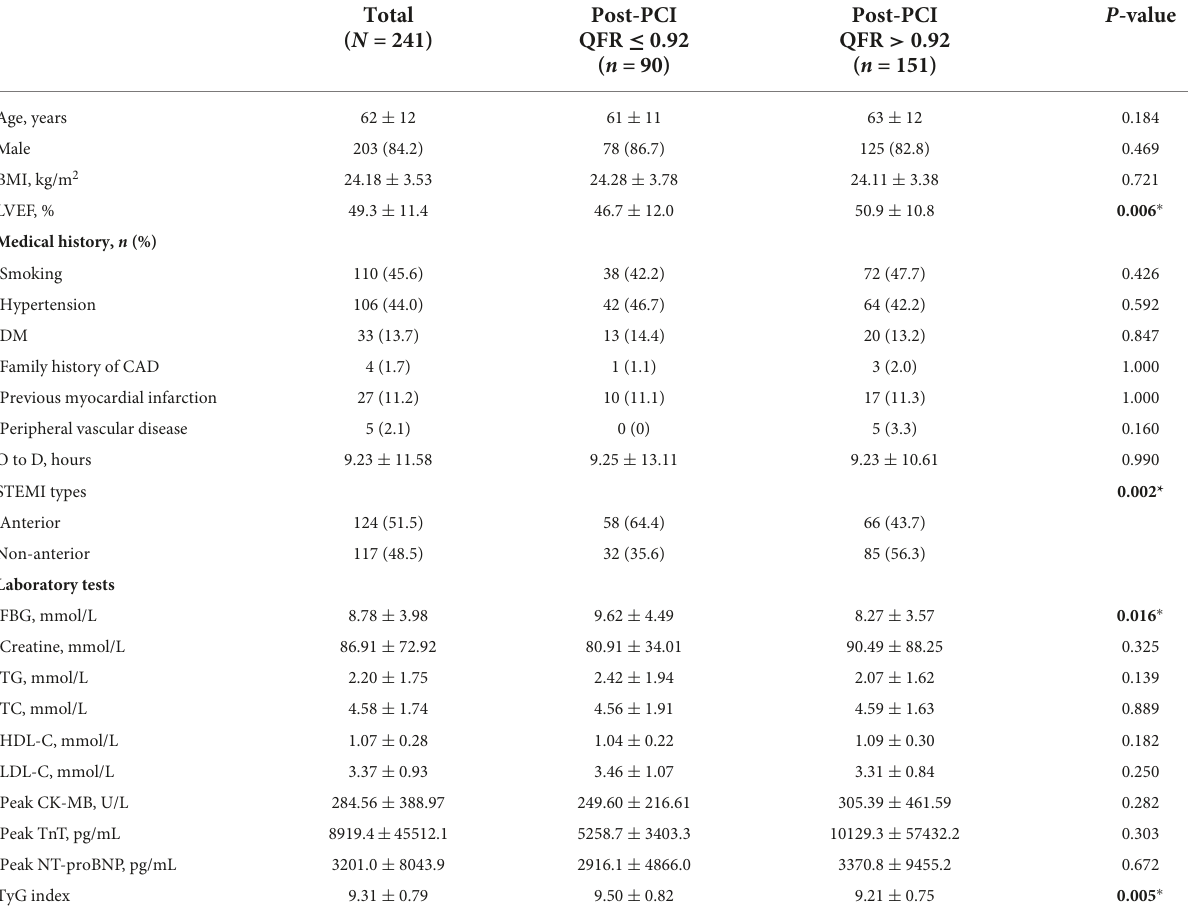
TABLE 1 Baseline